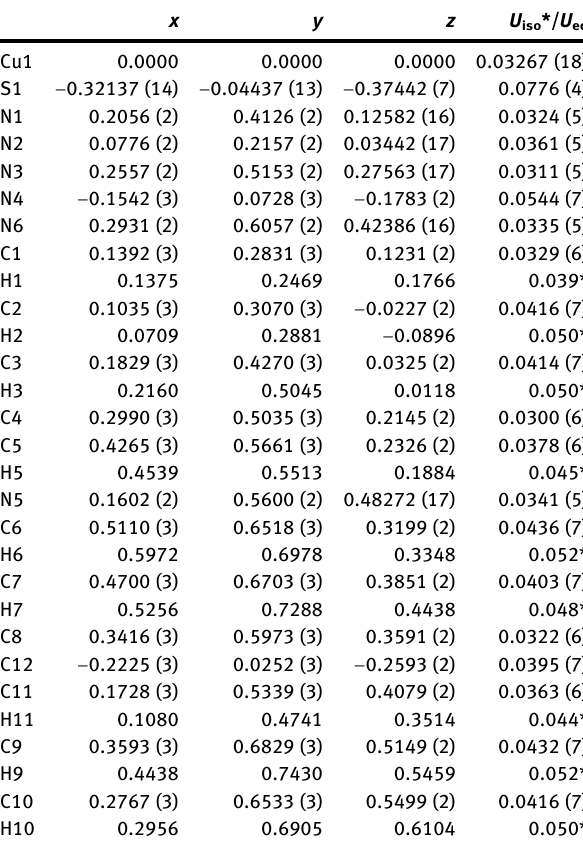
Table  : Fractional atomic coordinates and isotropic or equivalent isotropic displacement parameters (Å 